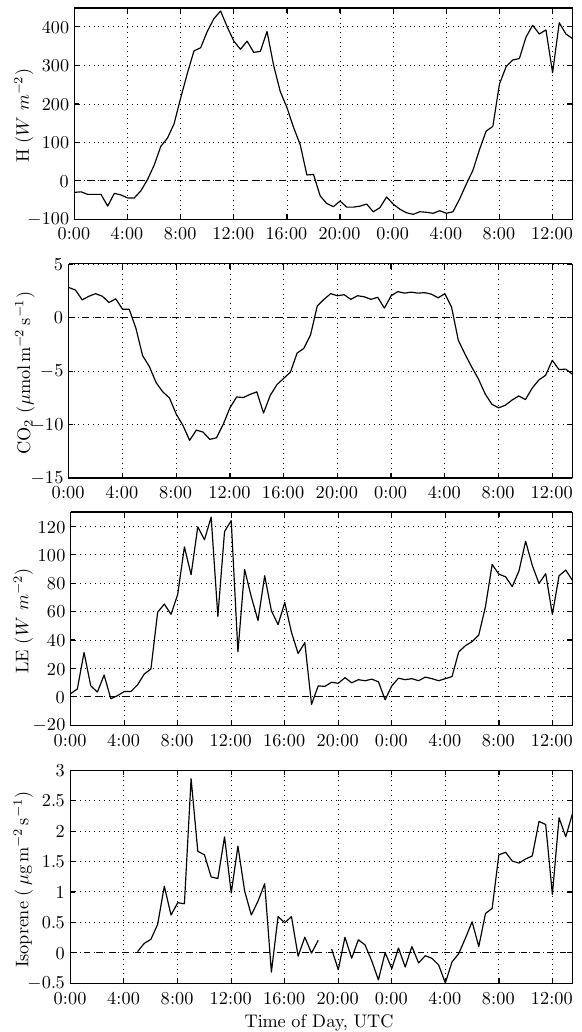
Fig. 11. From top to bottom: sensible heat flux (Wm − 2 ) , CO 2 flux (µmolm − 2 s − 1 ) and latent heat flux (Wm − 2 ) measured with the eddy covariance method, and Isoprene flux (µgm − 2 s − 1 ) computed with the disjunct eddy covariance method. The measurement period was on 5 and 6 August